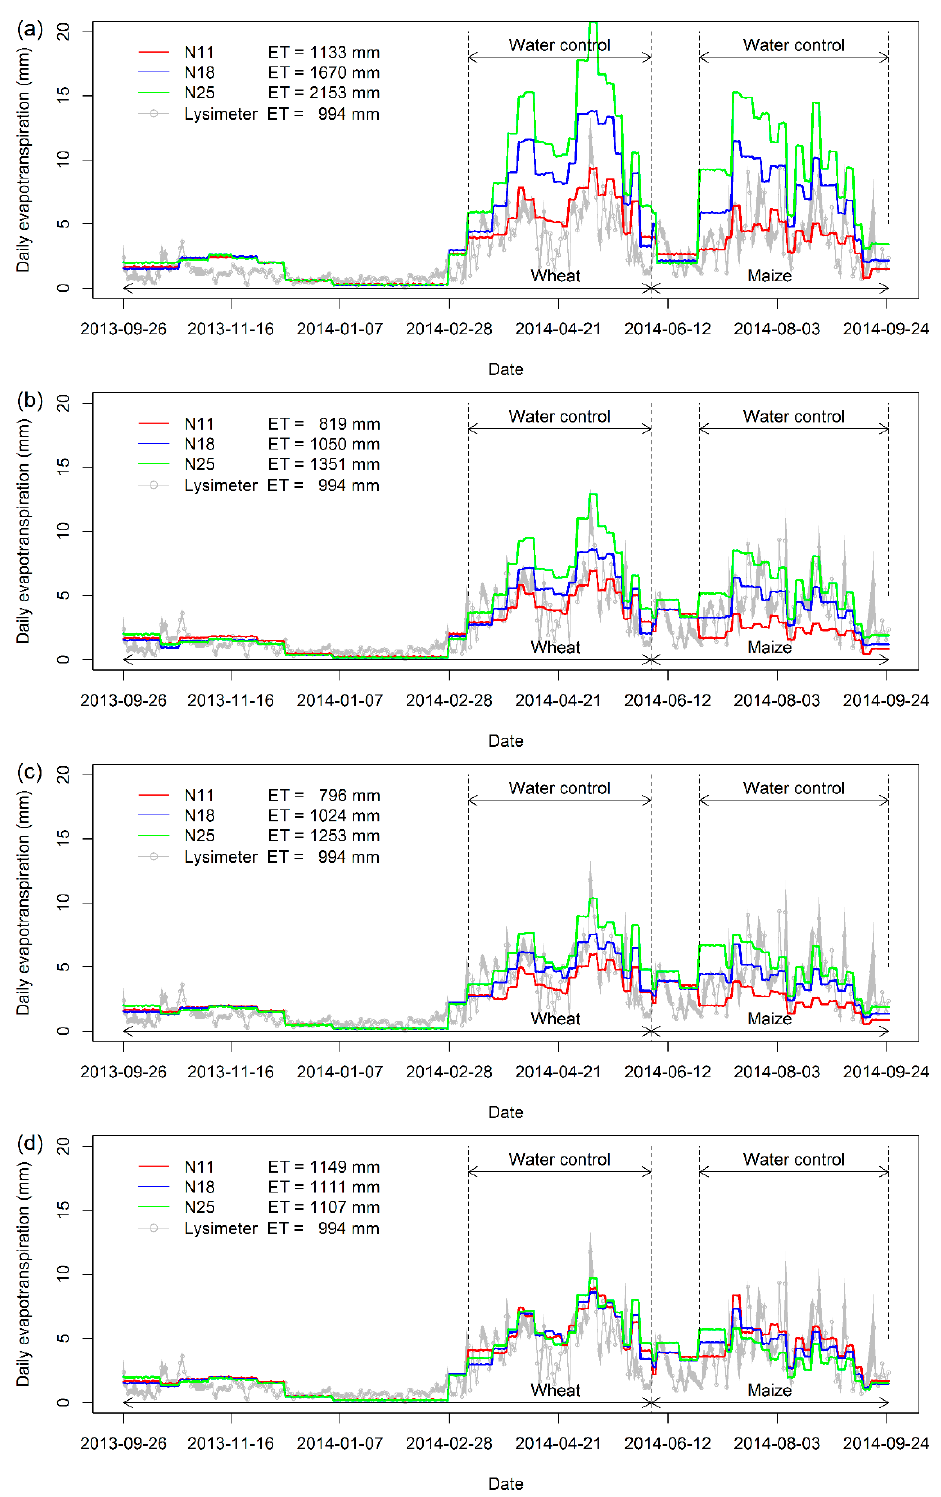
Figure 10. Comparisons between ( a ) uncorrected, ( b ) density-corrected, ( c ) area-corrected, and ( d ) biomass-corrected daily ET for pots and those for lysimeters. N11, N18, and N25 correspond to 11%, 18%, and 25%, respectively, for normal pots with crops.